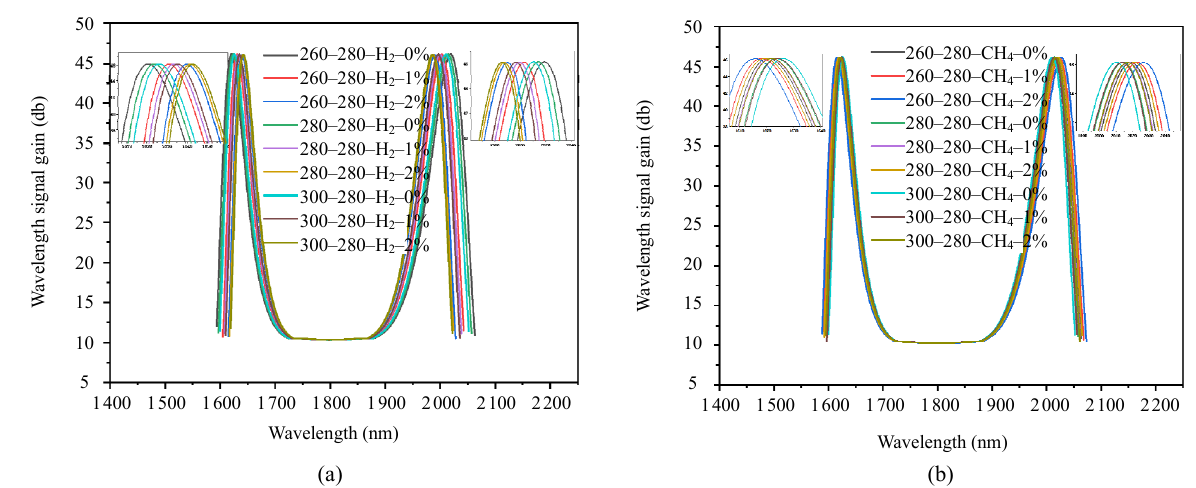
Fig. 5 Stokes and anti-Stokes gain spectrum curves with the variation of the hydrogen concentration (a) and Stokes and anti-Stokes gain spectrum curves with the variation of the methane concentration